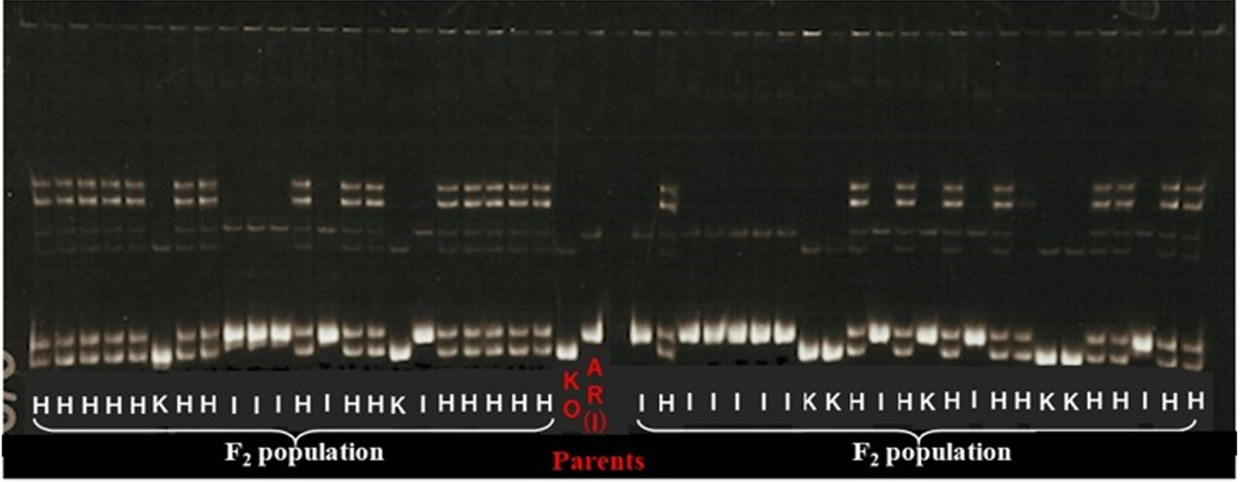
Figure 4. Banding pattern of linked marker E60663 on chromosome 5 with the highest likelihood ratio of putative QTL under SIM and CIM. K represents Koshihikari banding profile; H is denoted as heterozygous while I banding pattern follows ARC7013 in F 2 population. In the middle of the gel, a control ladder containing both parents are loaded and labelled as red.